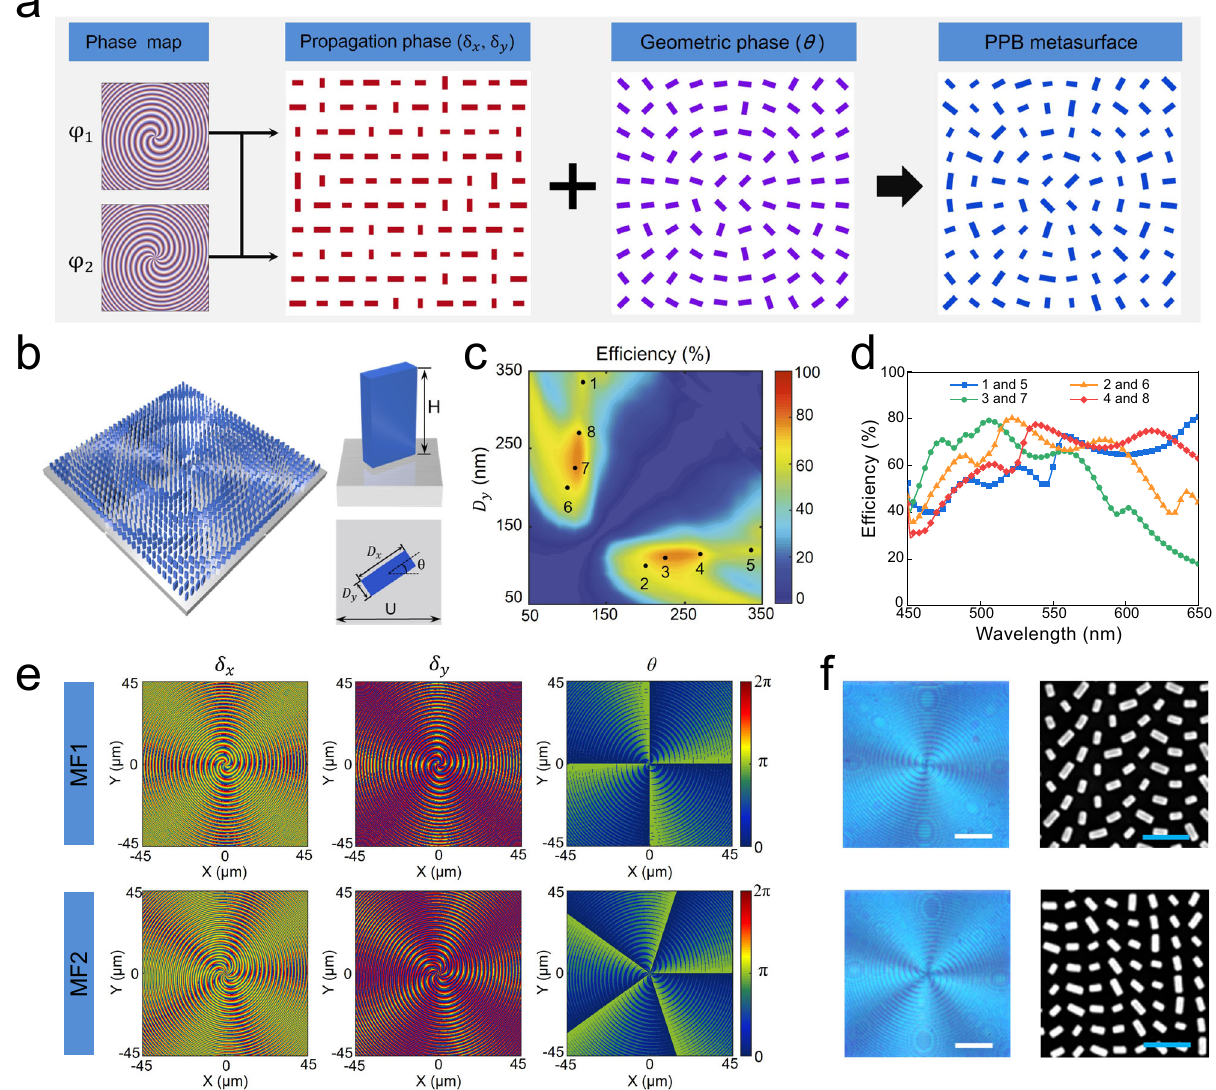
Fig. 2 Design of a single-layer metasurface. a A general metasurface design method to generate arbitrary PPB. Given two arbitray phase map ( φ 1 , φ 2 ) for generation of different perfect vortices, the phase shifts ( δ x , δ y ) and rotation angle θ of metasurface pixels are calculated and utilized to design nanopillars with varying in-plane dimensions and orientation angle. b Left: schematic of the metasurface made up of TiO 2 rectangle nanopillars. Right: perspective view and top view of the unit cell arranged on a fused-silica substrate. c Calculated polarization conversion ef fi ciency as a function of nanopillars ’ in-plane dimensions at a design wavelength of 530 nm. The black dots denote the selected nanopillars in constructing MF1 and MF2. d Calculated polarization conversion ef fi ciencies of the selected eight nanopillars across the visible band. e The phase shifts ( δ x , δ y ) and rotation angle θ of the birefringent TiO 2 nanopillars as a function of the spatial coordinates in the metasurface (MF1 and MF2) plane. f Left: optical microscope images of the fabricated metasurfaces: MF1 (top) and MF2 (bottom). Scale bar: 20 μ m. Right: top view scanning electron microscopy (SEM) images of metasurfaces. Scale bar: 500 nanopillars as a function of diameters ( D x , D y ) at a wavelength subwavelength square lattice constant U . The nanopillars are of uniform heights H while their in-plane dimensions ( D x , D y ), and orientation angles θ vary spatially. In order to investigate the transmission properties of rectangular TiO 2 nanopillars, full-wave simulations are performed using the fi nite-difference time- domain (FDTD) technique. The height H of the TiO 2 nanopillars is set as 600 nm to achieve the desired 2 π phase coverage. The lattice constant U is chosen to be 450 nm, which guarantees that the nanopillars array act as a zeroth-order grating 22 with relatively high transmission in the visible range. Supplementary Fig. 1 shows the simulated phase shifts and transmission coef fi cients of x - and y -polarized light for the rectangular